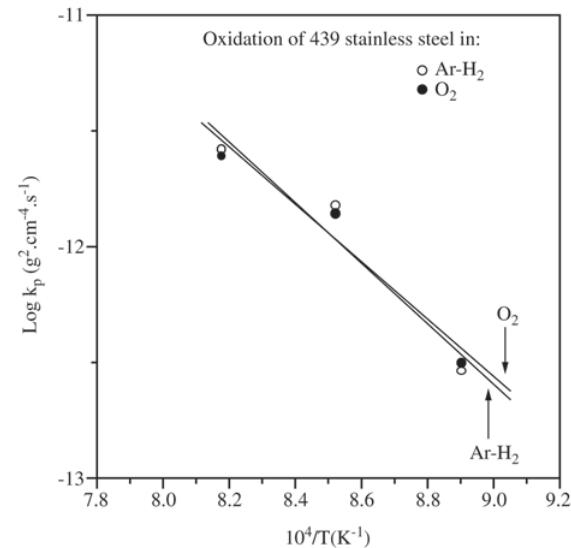
Figure 12. Arrhenius plot of the parabolic oxidation constants of 304 and 439 steels in oxygen.